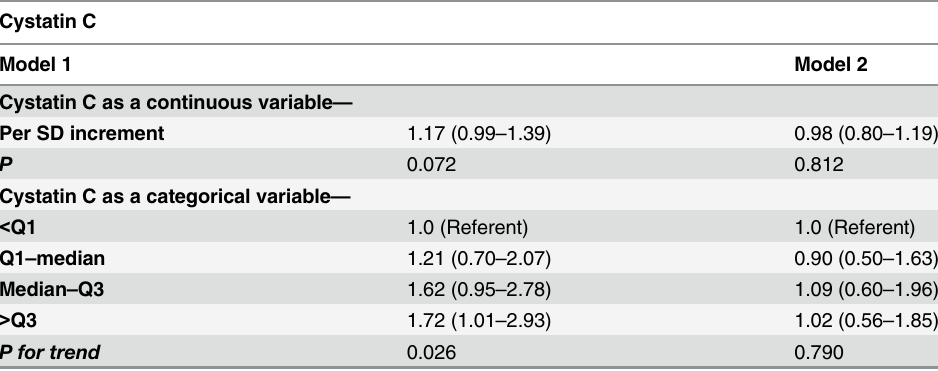
Table 2. Cystatin C and risk of future metabolic syndrome in the MDC-CC-re-examination-replication-